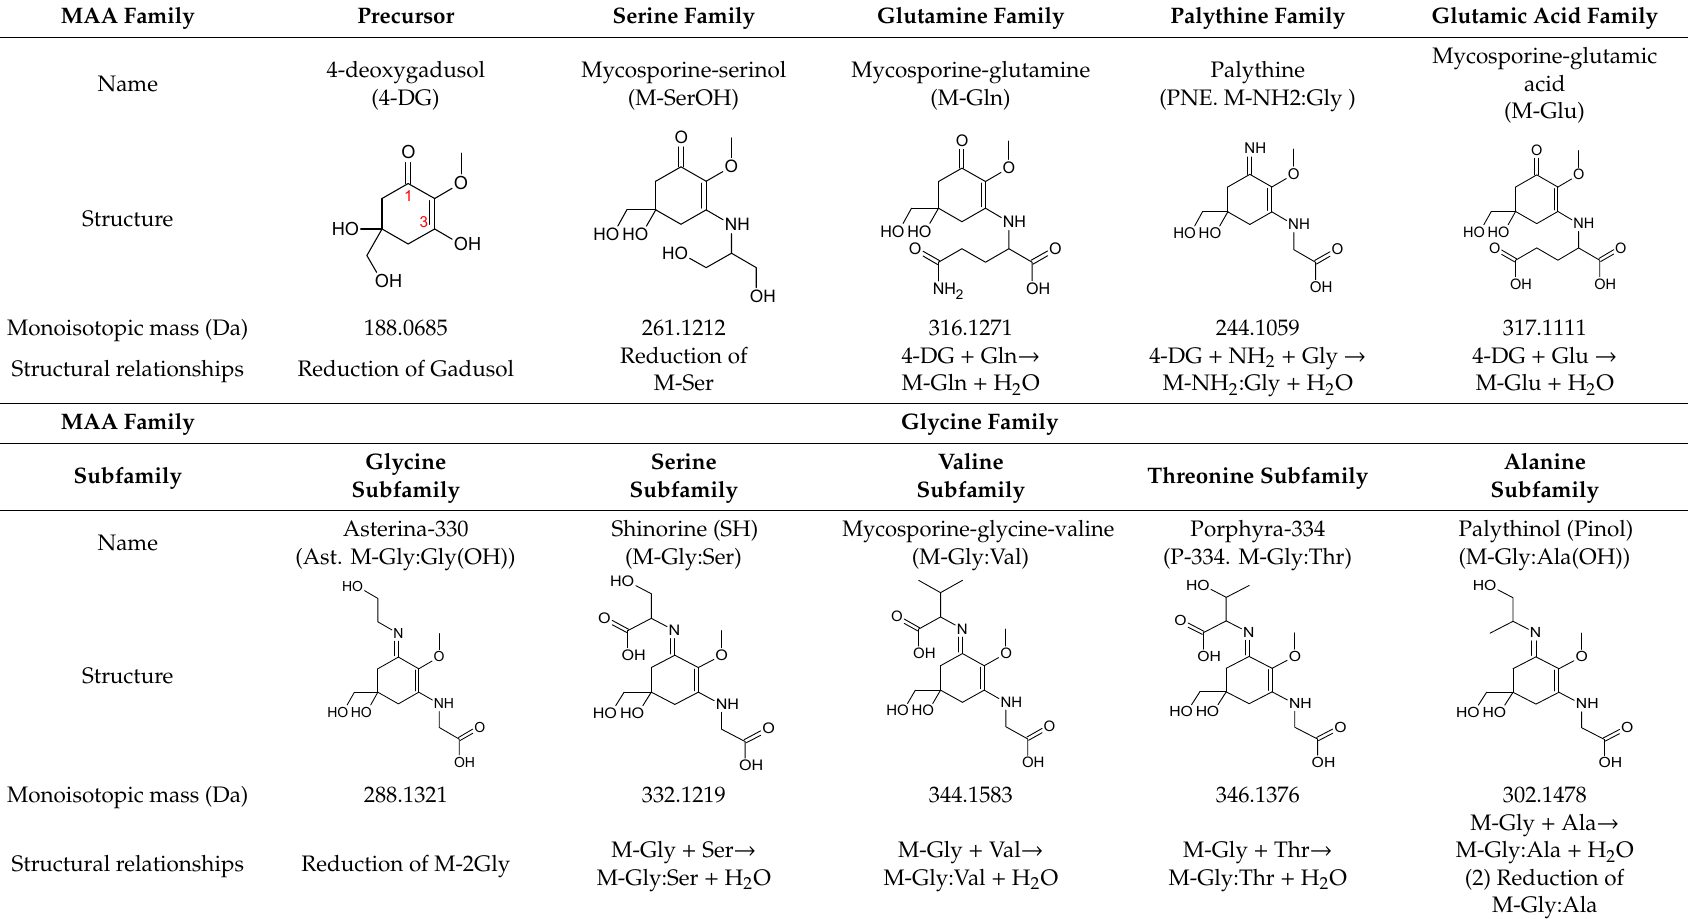
Table 2. Inventory of MAAs identified in targeted HPLC-ESI-MS methods operated in positive mode. Marine Organisms